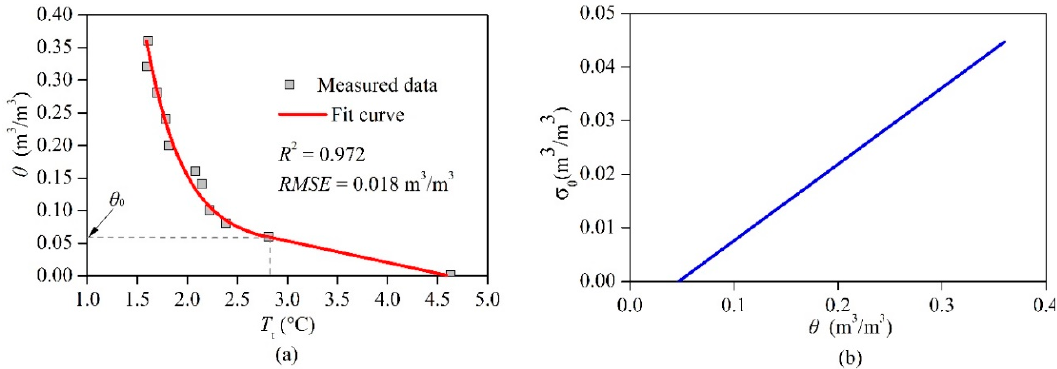
Figure 6. Laboratory calibration results: ( a ) fitted results between the soil moisture content and the temperature changes of the ATPS, and ( b ) the calculated error ( σ θ ) variation with the increase of the actually measured soil moisture content obtained by the oven drying method. R 2 is the coefficient of determination of a piece functional regression, root mean square error ( RMSE ) is defined as the standard deviation of the residuals, and T t refers to the temperature characteristic value.